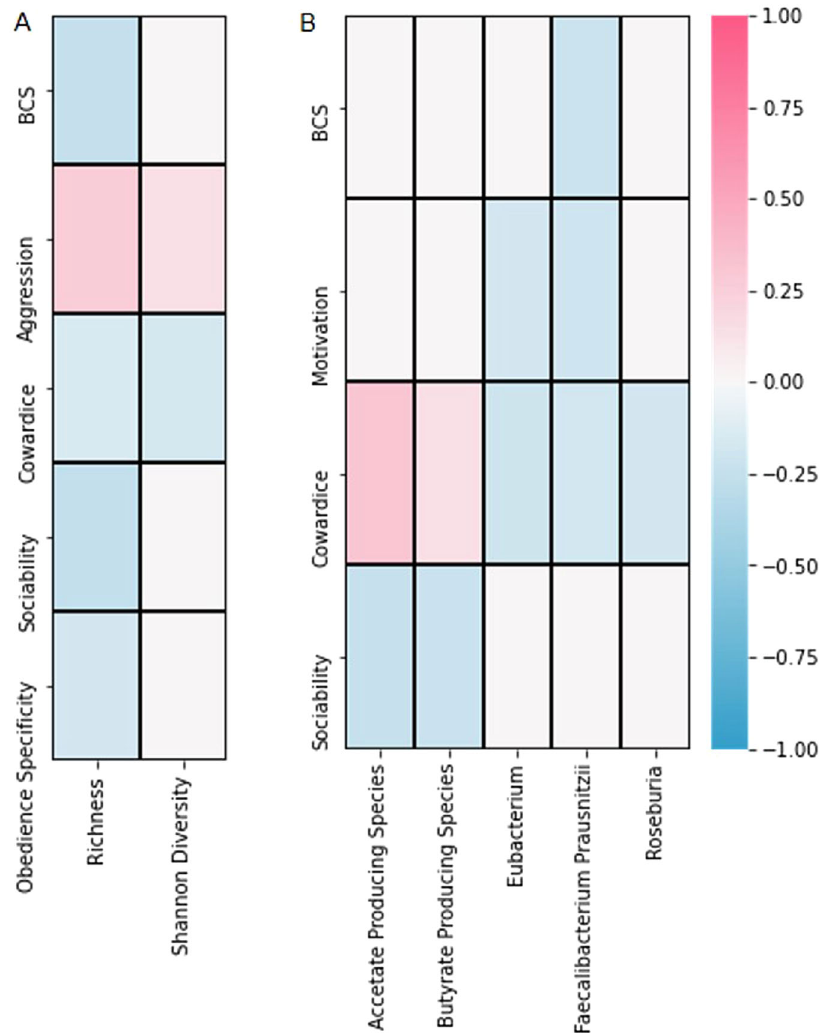
Fig. 7 Heatmap depicting correlation among microbiome features and canine demographic and phenotypic data. A Microbiome features including richness and diversity. B Speci fi c microbial group. Only values signi fi cant after false discovery rate (FDR) correction (level = 0.15) are presented in this fi gure. BCS body condition